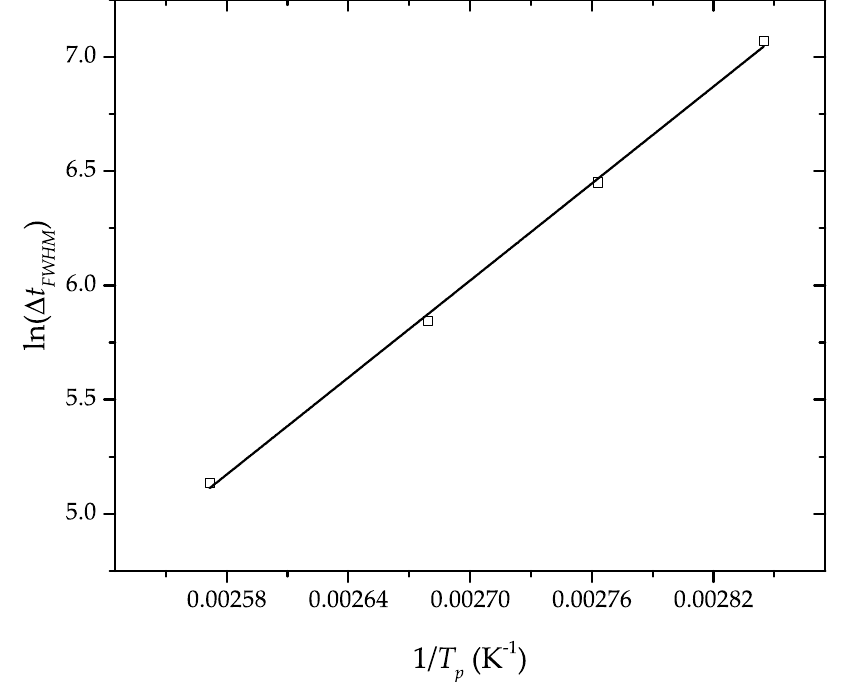
Figure 6. Plot of ln ∆ t FWHM vs 1/ T p to check the assumptions of the Kissinger method corresponding to the crosslinking of a partially bio-based epoxy resin for different heating rates, β